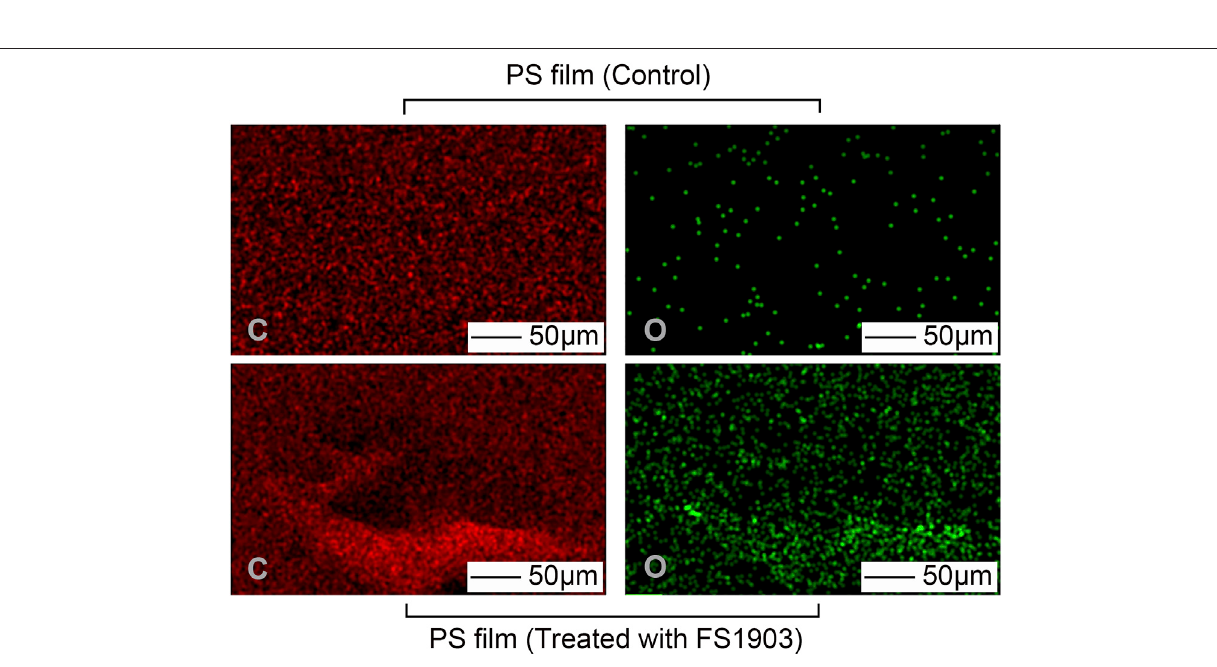
Frontiers in Bioengineering and Biotechnology |